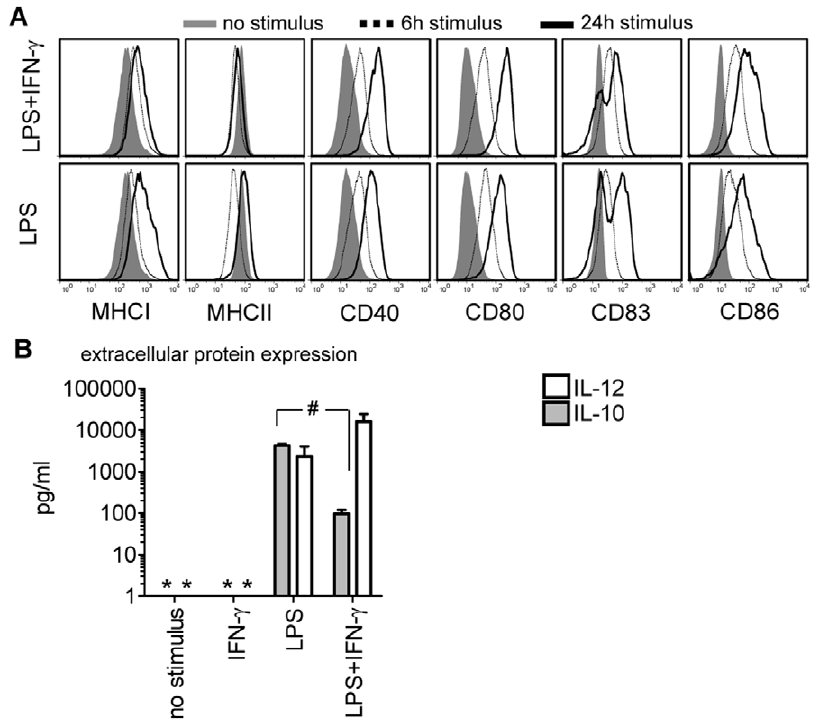
Figure 1. Detection of immune-modifying molecules in maturing human DCs. (A) DC membrane molecule expression at 6 (dotted line) and 24 hours (black line) after LPS or LPS/IFN- c exposure compared to un-stimulated human DCs (filled gray histograms). One representative out of 3 experiments is shown (donor C). (B) LPS or LPS/IFN- c induced IL-12 (white bars) or IL-10 (grey bars) protein secretion was measured 48 hours after exposure to the different stimuli (p=0.006). As a control, DCs were stimulated with IFN- c or cultured without stimulation for 48 hours. Data are pooled from 4 experiments and depicted as median 6 SEM (donors A–D). Asterisks indicate cytokine levels below the detection limit of the assay. doi:10.1371/journal.pone.0054879.g001 a in the co-culture supernatants when LPS/IFN- c was used as DC stimulus (figure 2B ii & C ii , table 2). In agreement with the secretion kinetic release of IL-10 was detectable within these DC/ T-cell priming cultures.